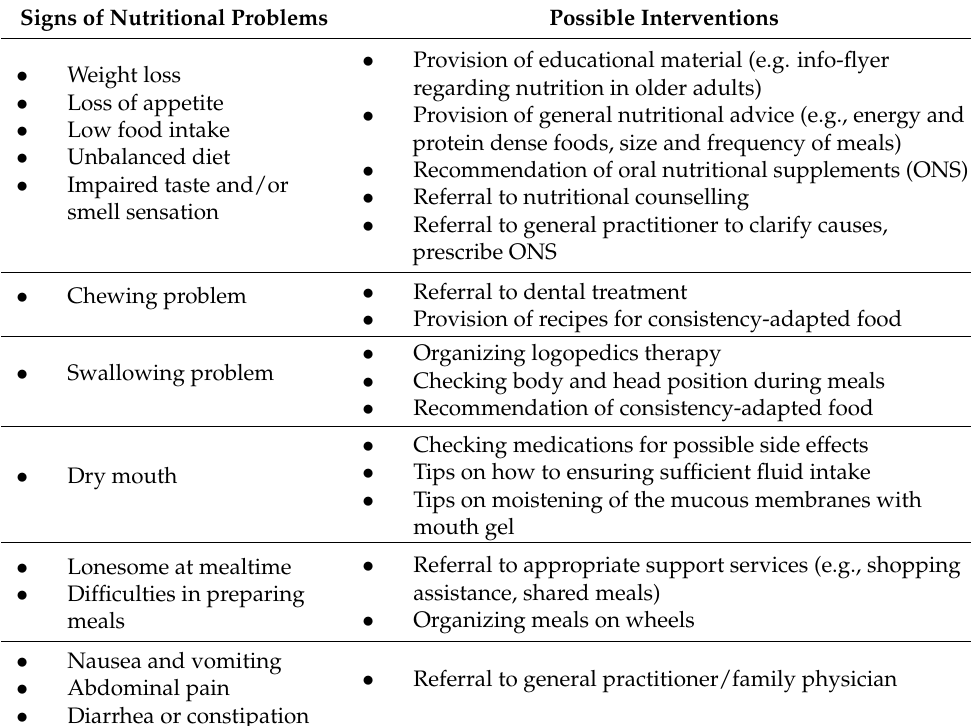
Table 1. Signs of nutritional problems and possible interventions by